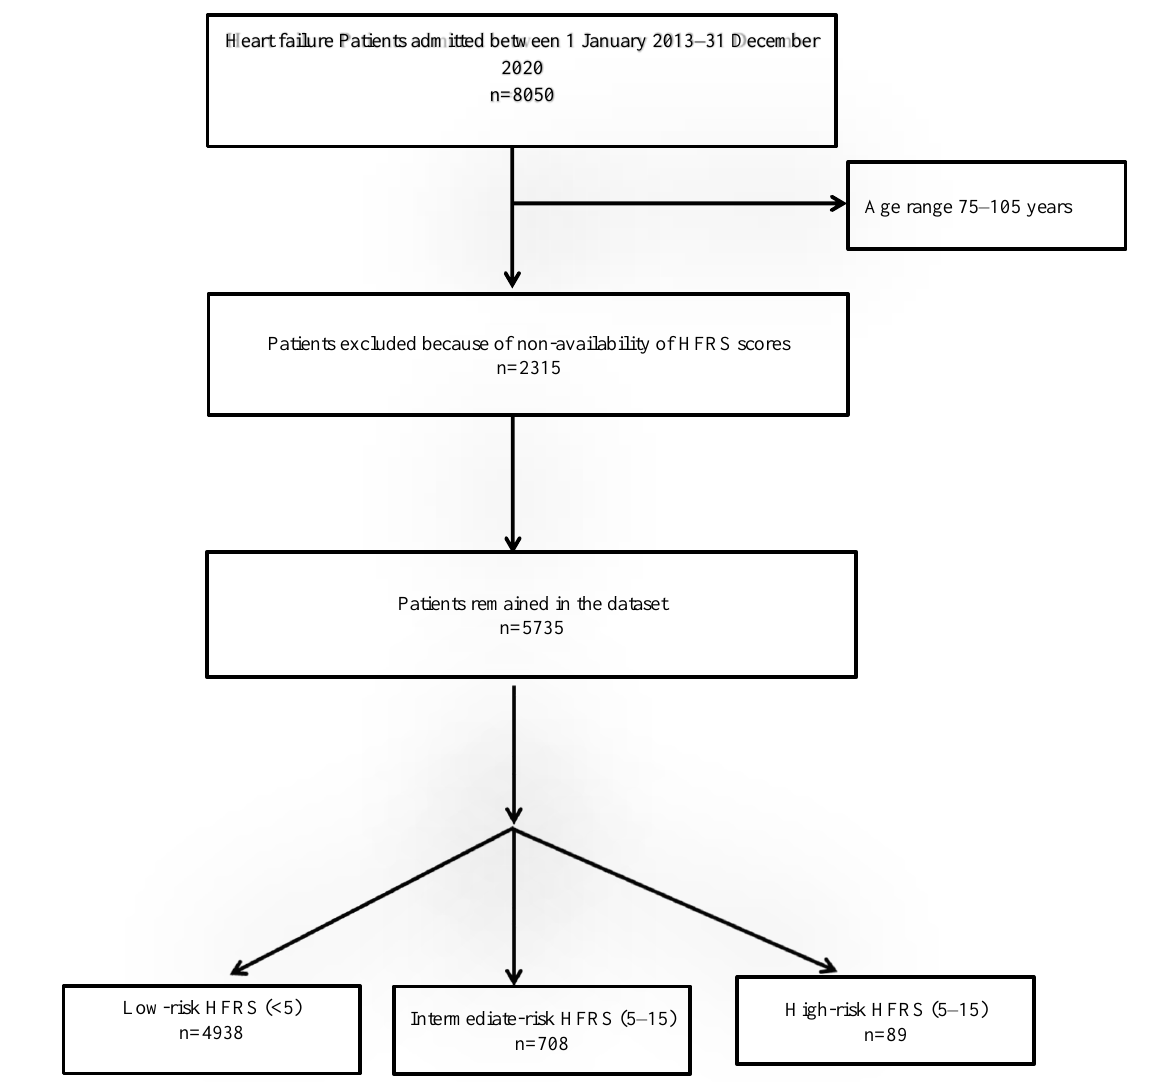
Figure 1. Study flow diagram. Table 1 . Baseline characteristics of patients .